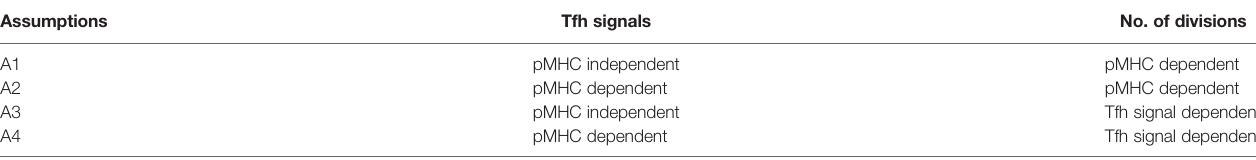
TABLE 1 | Assumptions considered for the